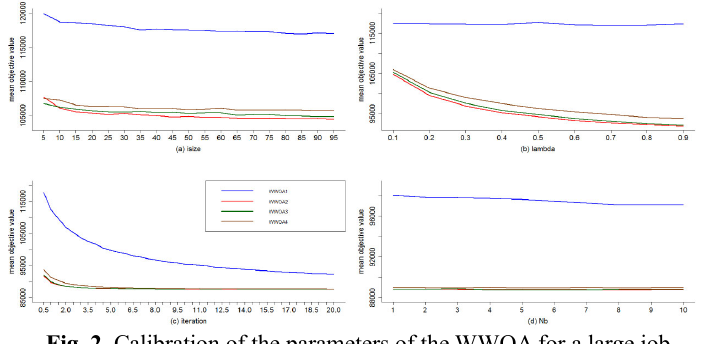
Fig. 2. Calibration of the paramete rs of the WWOA for a large